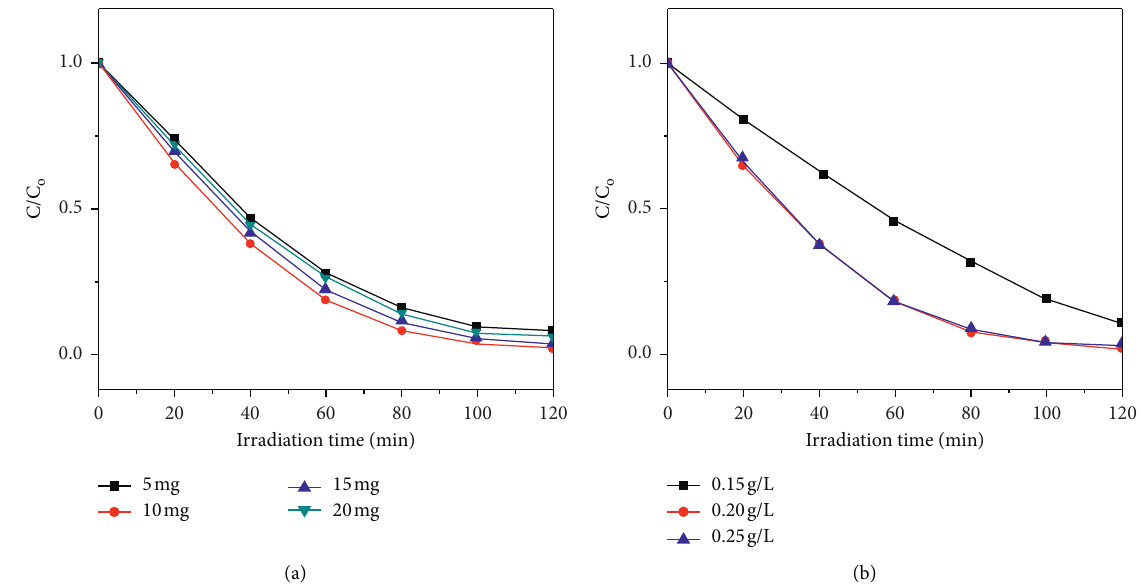
Figure 11: The effect of photocatalyst dosage (a) and concentration (b) on MB removal under UV light irradiation.